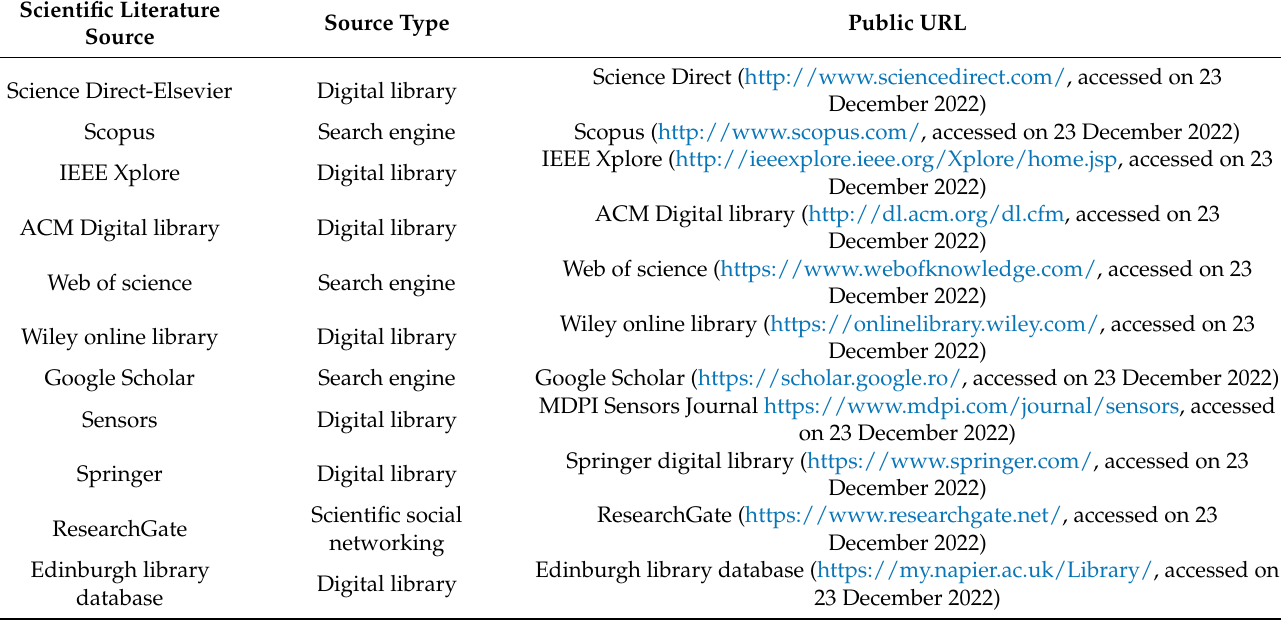
Table 1. Considered scientific literature